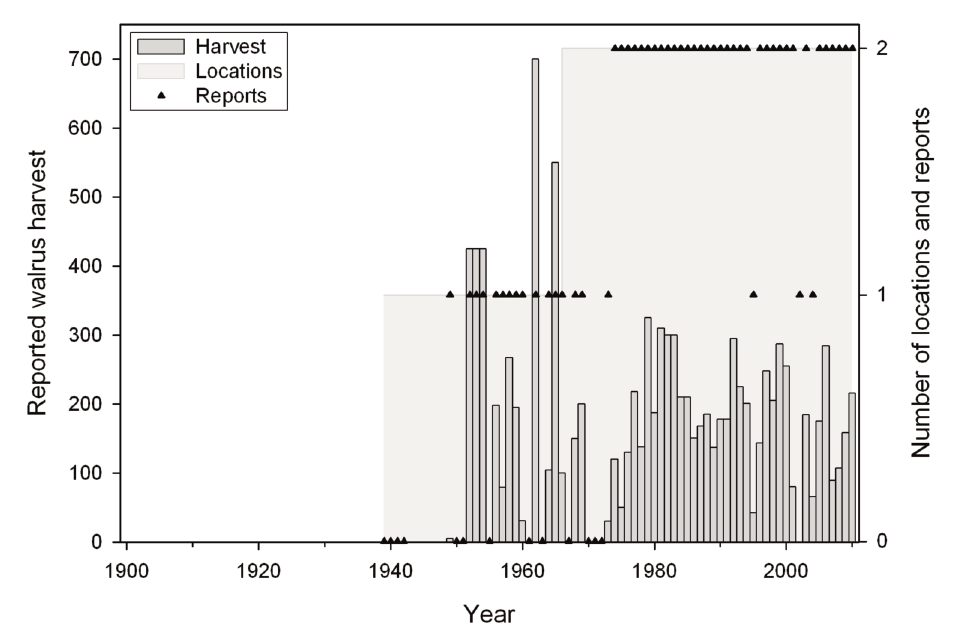
Fig. 17. Catches by Inuit and shore-based traders, and community reporting rates, from the Foxe Basin (FB) stock of the Canadian Central Arctic walrus population, 1900–2010. Recent sport hunts not